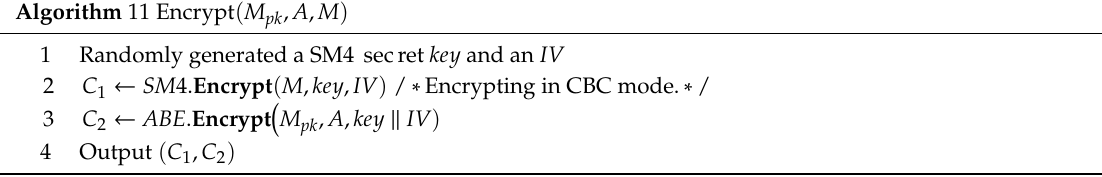
Algorithm 11 Encrypt ( M pk , A , M )